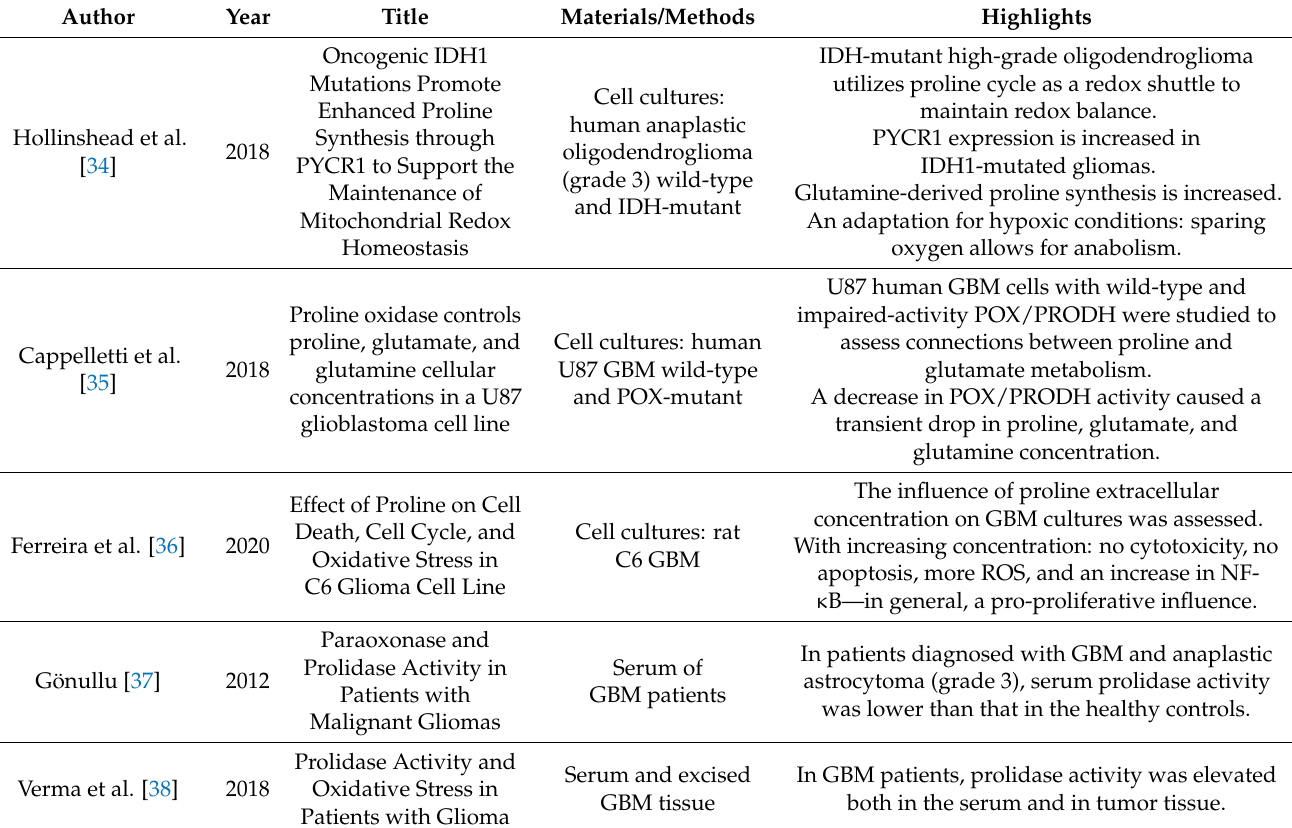
Figure 3. Flowchart of the systematic literature review and meta-analysis according to the PRISMA guidelines. Created with BioRender.com, accessed on 2 February 2022. Table 1. A summary of 14 articles chosen for systematic review.